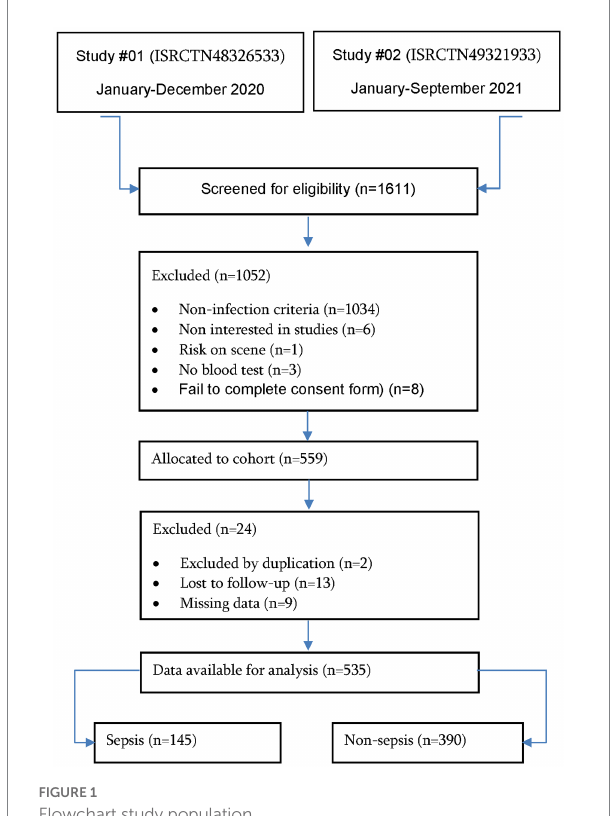
FIGURE 1 Flowchart study